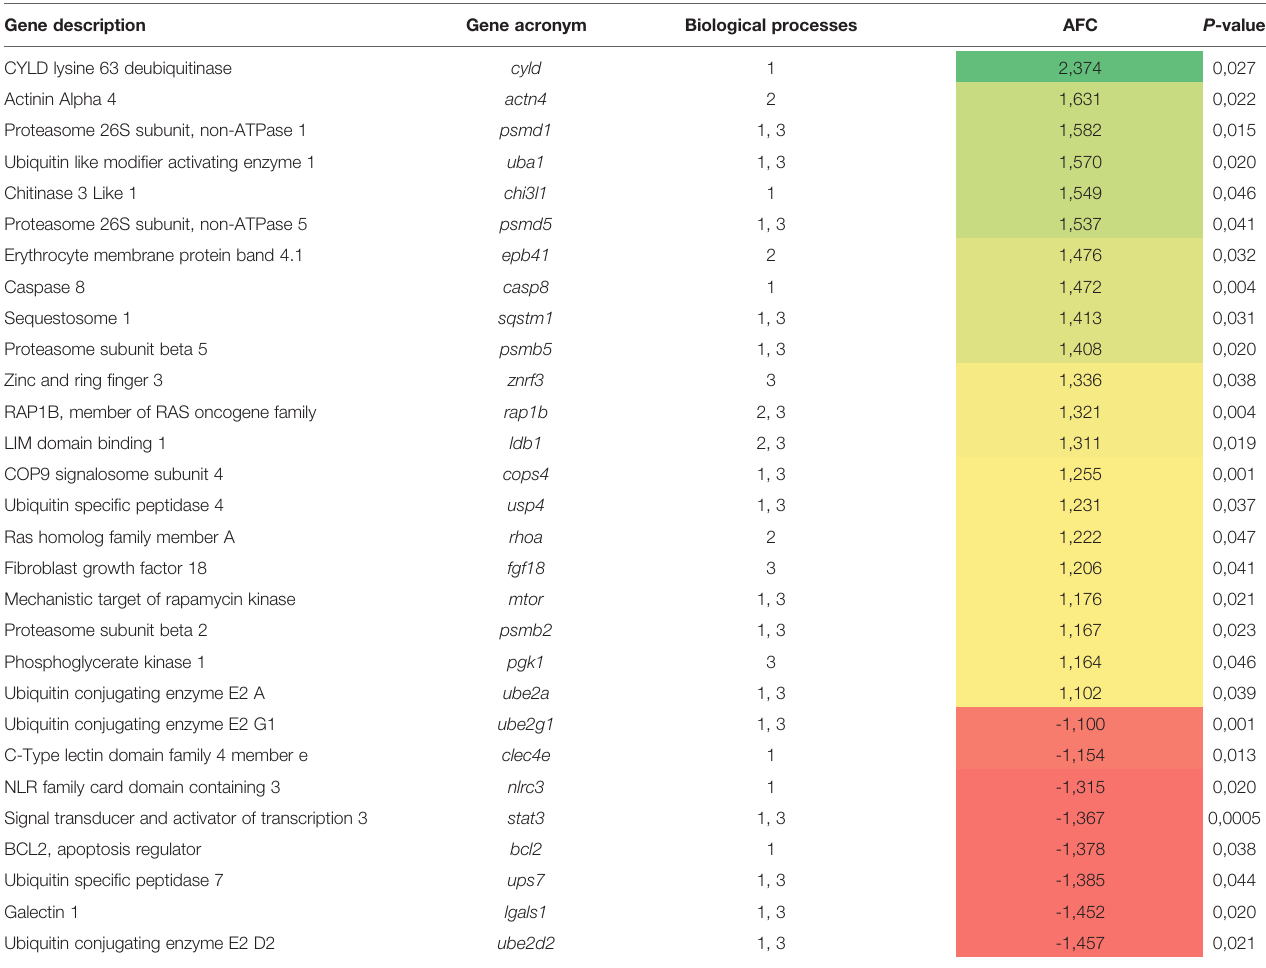
TABLE 3 | List of the most relevant DEGs related to three main representative biological processes identi fi ed by the transcripteractome (1, immune system processes; 2, cellular development and organization; 3, cellular catabolism) in fi sh fed the MPLE diet. Gene